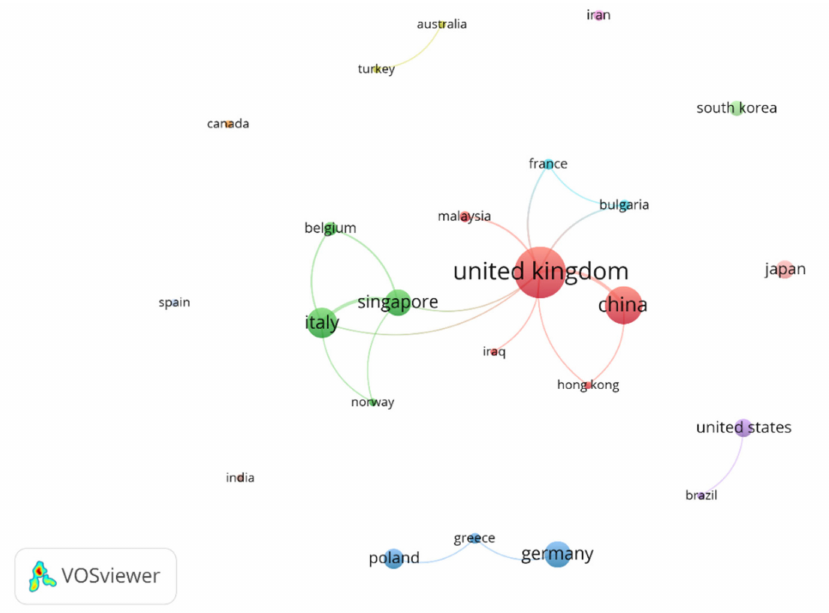
Figure 10. Network of the di ff erent countries elaborated with